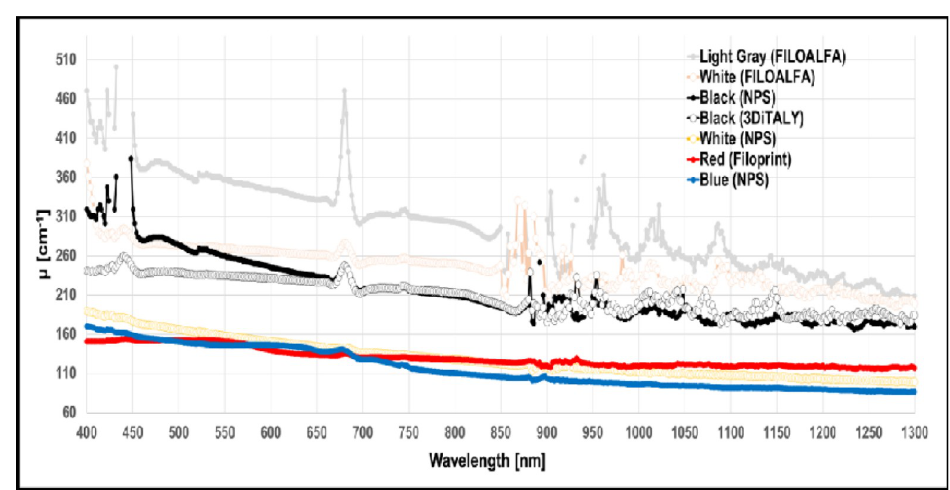
Fig 6. Extinction coefficient μ spectra in the wavelength range 400–1300 nm for ABS filaments with different colors from diverse producers.